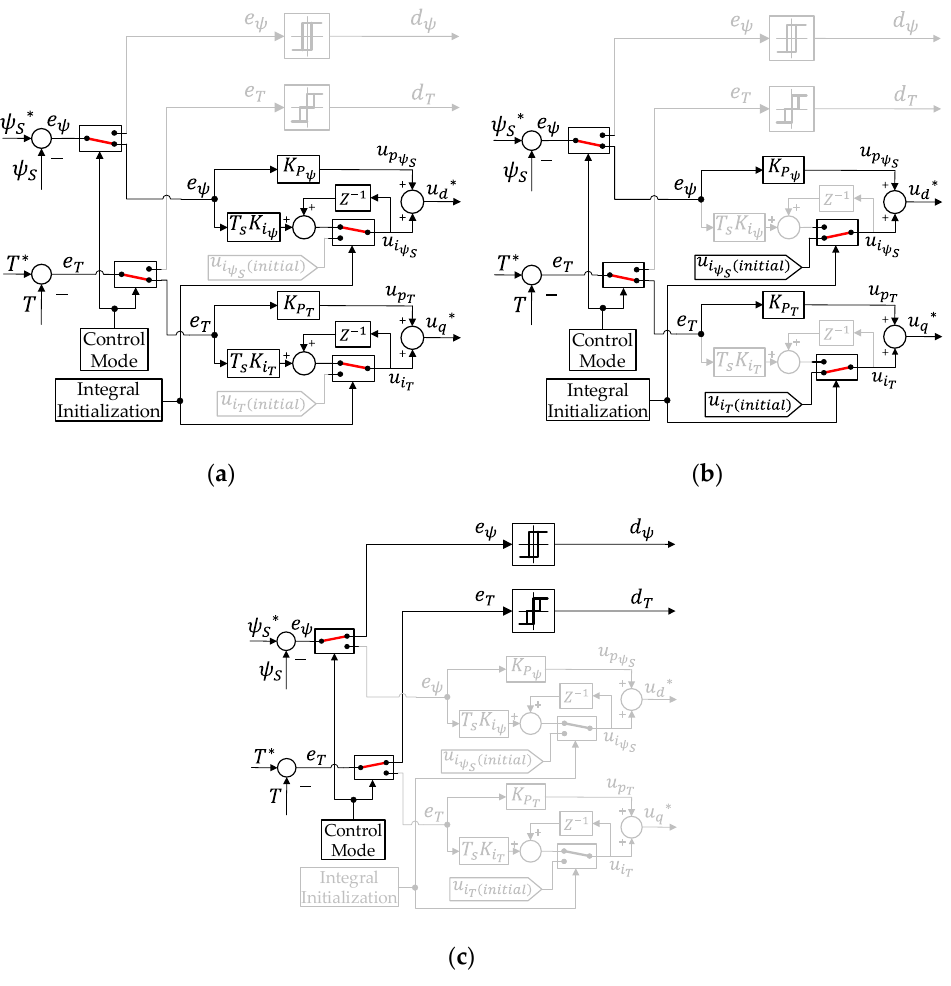
Figure 13. Control structure in detail: ( a ) DTC – SVM, ( b ) transition from conventional DTC to DTC – SVM and ( c ) conventional DTC.